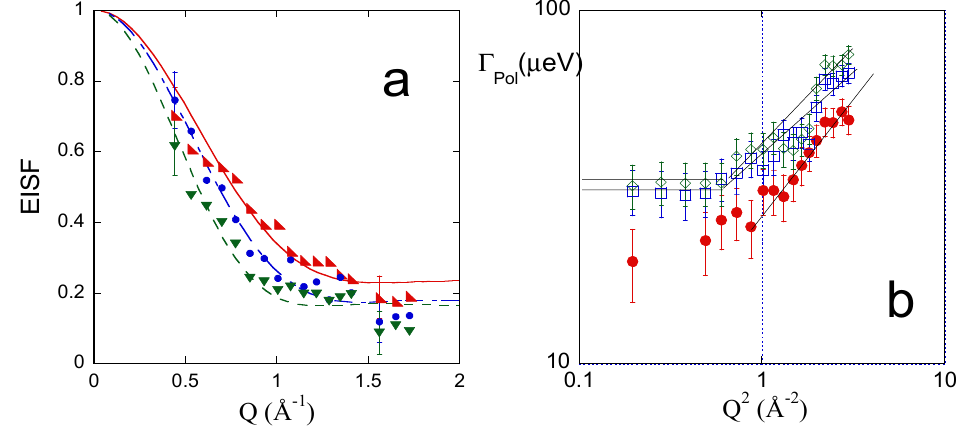
Figure 9. Q behavior of (a) EISF and (b) Γ symbols) and 313 K (green